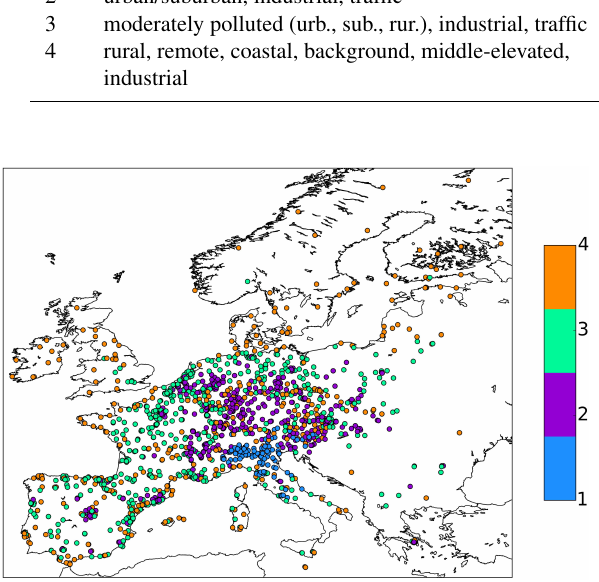
Figure 4. Map of 1492 Airbase stations clustered in four groups; second CA.